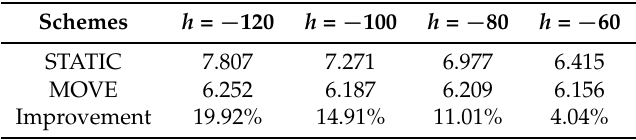
Figure 4. The tracking error comparison between MOVE and STATIC with different adjacent node distance. ( a ) tracking errors for MOVE and STATIC with adjacent node distance dis = 90 (over 100 MC runs); ( b ) tracking errors for MOVE and STATIC with adjacent node distance dis = 150 (over 100 MC runs); ( c ) tracking errors for MOVE and STATIC with adjacent node distance dis = 180 (over 100 MC runs); ( d ) average tracking errors for MOVE and STATIC with different adjacent node distance (over 100 MC runs). Table 1. Average tracking errors with different moving depth h